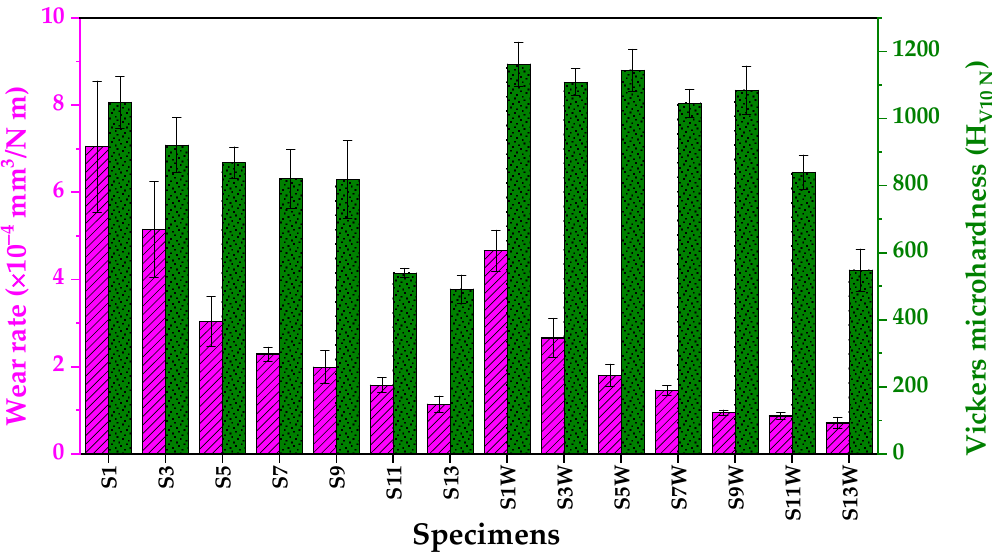
Figure 18. The wear rate and Vickers micro-hardness (HV10 N) of the PEO-coated samples.